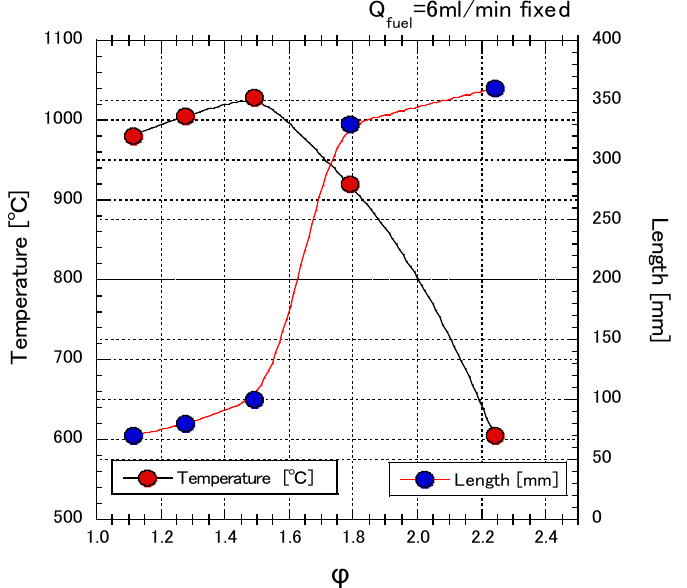
Figure 15. Relationship between the equivalent ratio when the swirling air flow is changed, the combustion chamber temperature, and the flame length (Q fuel = 6 mL/min fixed).